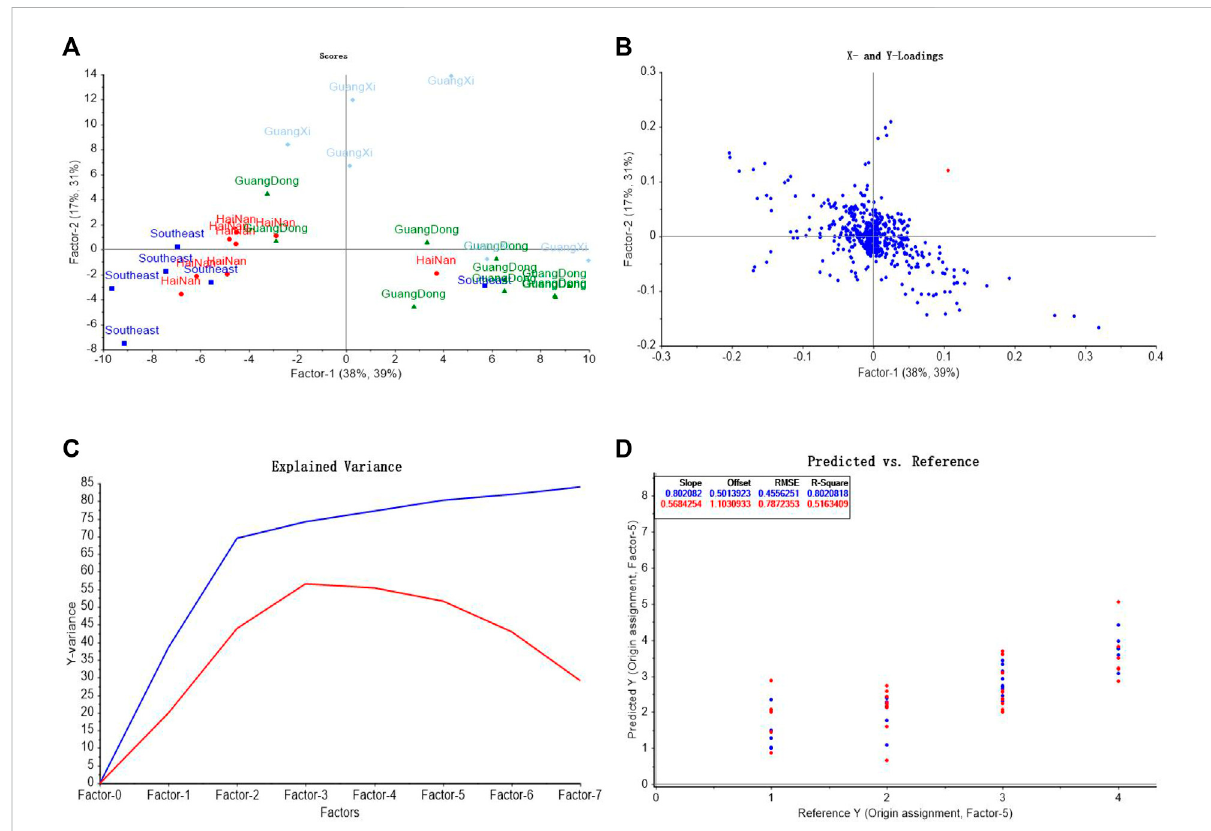
FIGURE 10 PLS-DAmodelanalysisofdifferentgeographicoriginsofAEOsamples. (A) PLS-DAscoregraph (B) Theloadingsofthe fi rsttwocomponentsfor PLS-DA; (C) Explained variance of factors in PLS-DA model (D) Comparison of predicted values and reference values of AEOs by